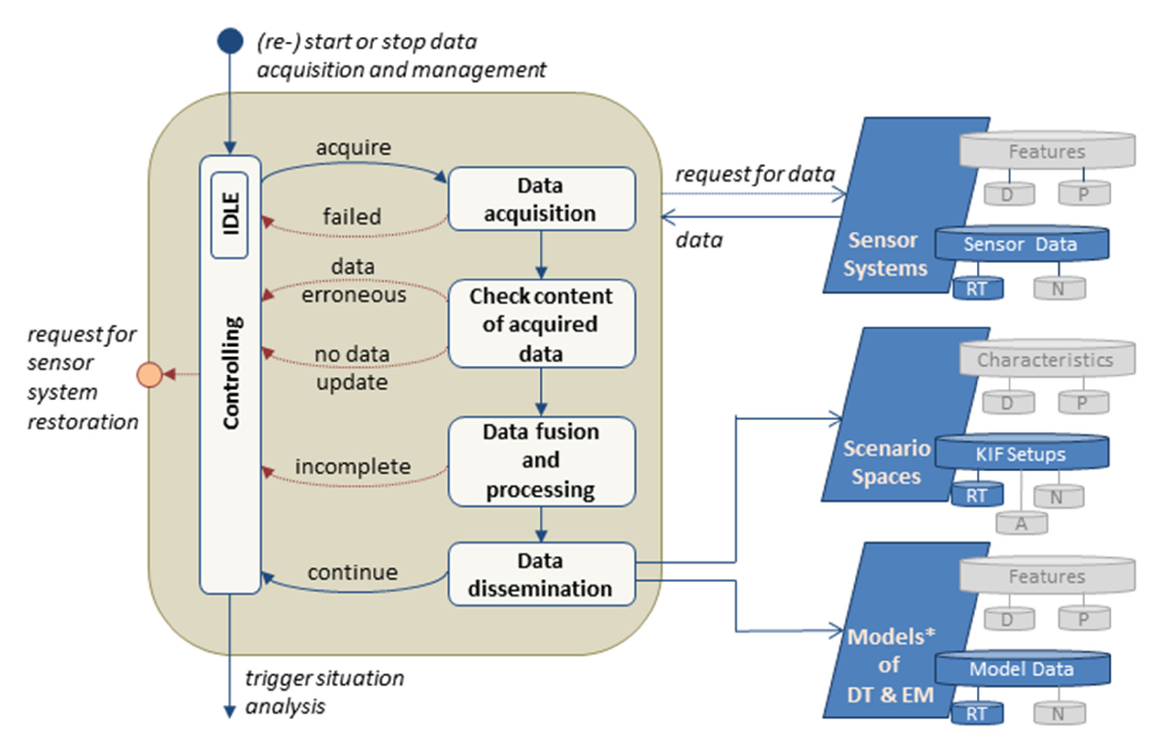
Figure 7. Flow chart of data acquisition and management.